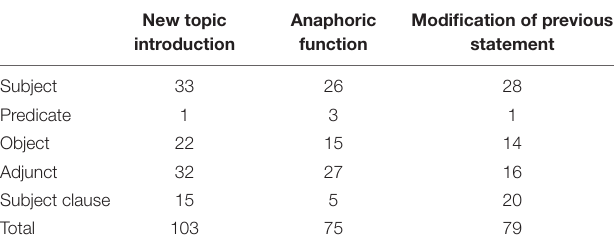
TABLE 4 | Discourse functions of pseudo-clefts in relation to clefted